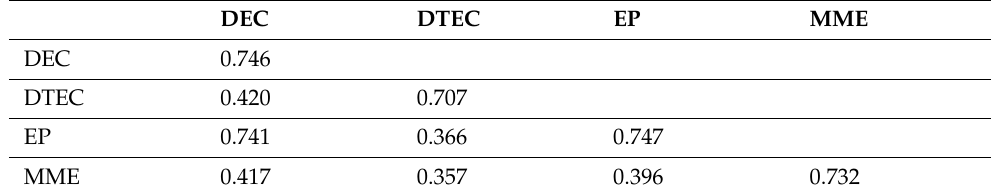
Table 4. Fornell-Larcker criterion.